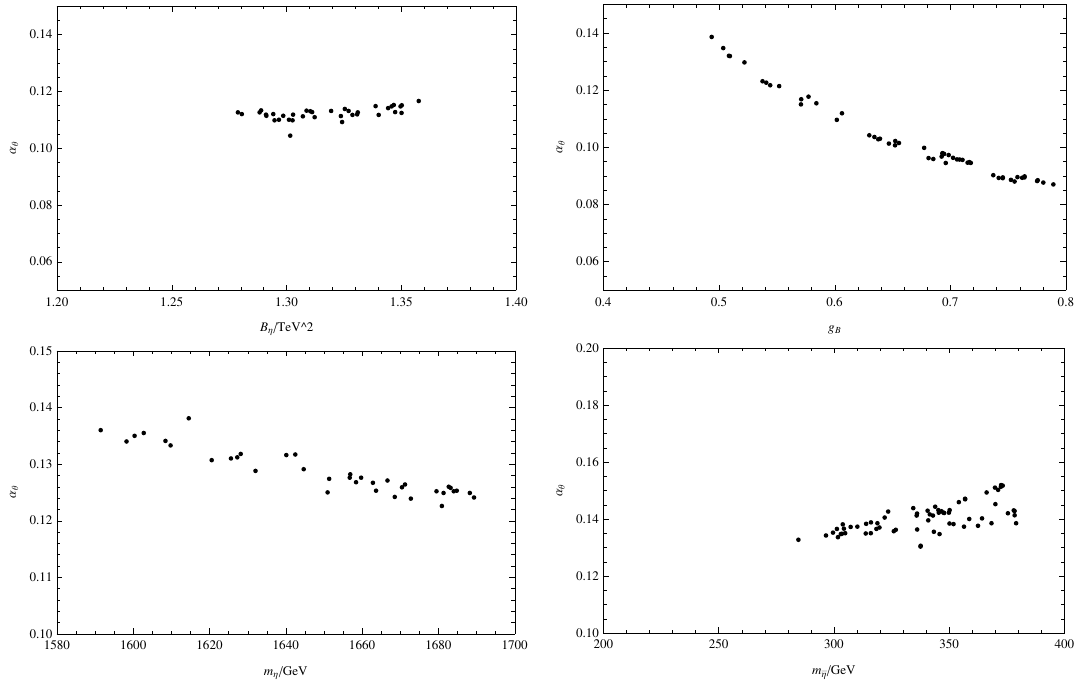
Figure 5 . The strengths of PT α θ change with the parameters B η , g B , m η and m